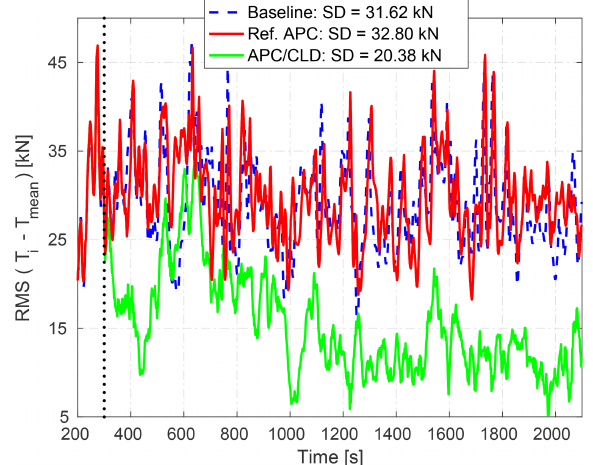
Figure 15. RMS errors between the applied thrust of the individual wind turbines and their mean value.